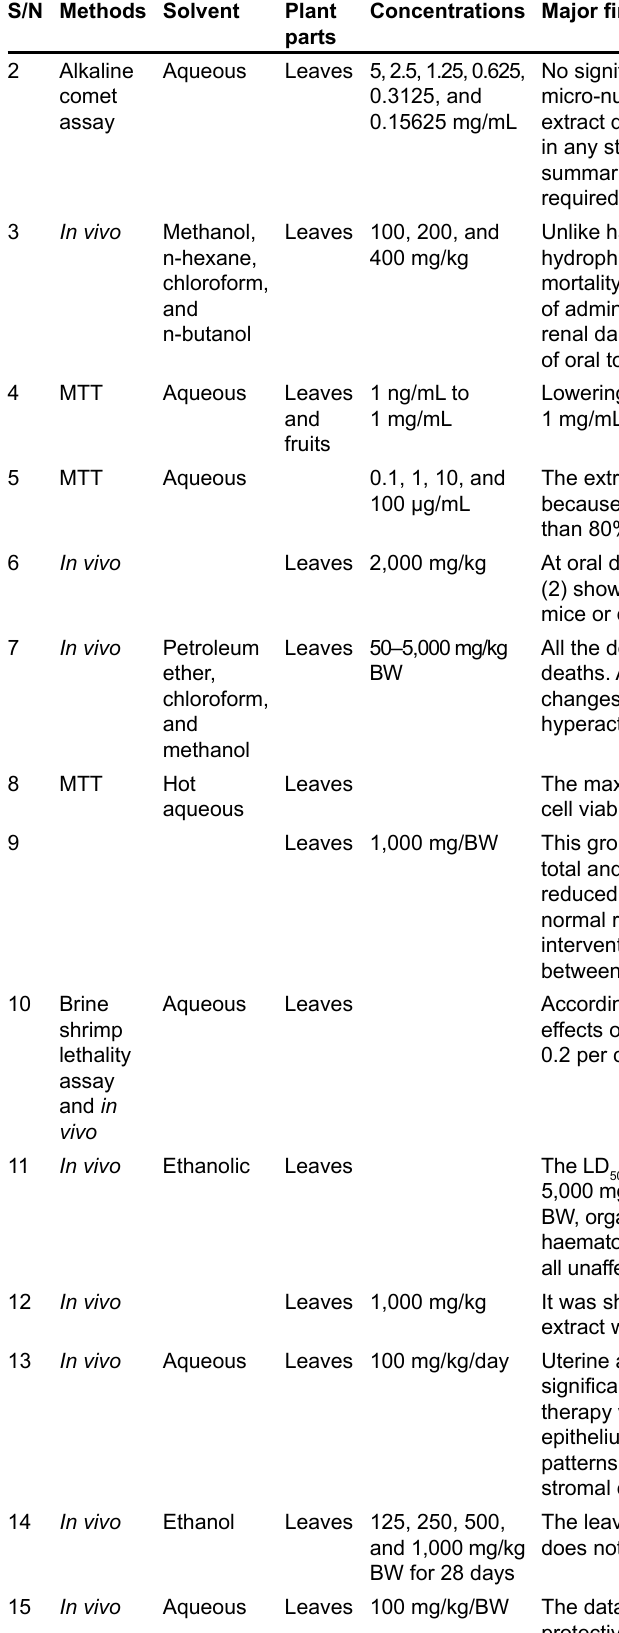
Table 9. Toxicity evaluation of FD ( continued ) S/N Methods